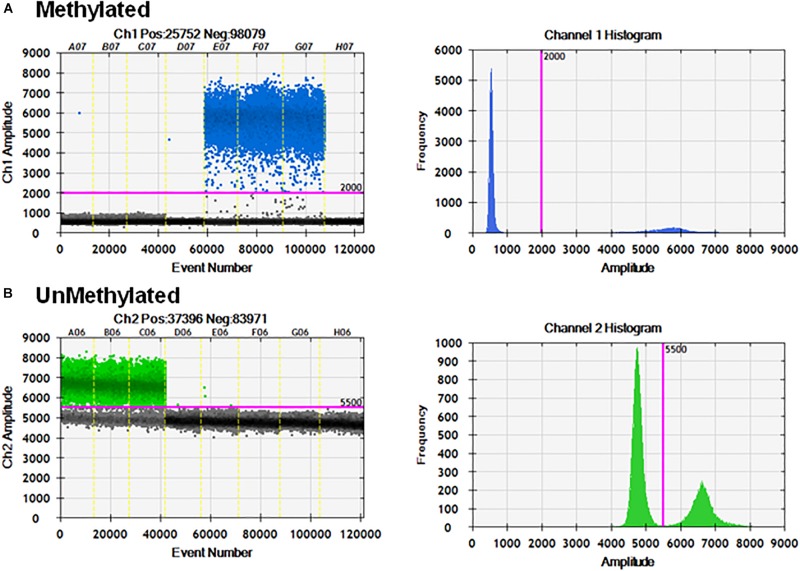
Specificity of ddMSP assay. ddPCR in the presence of mixtures of methylated and unmethylated plasmids. (A) Methylation probe and primers can only detect methylated CpGs and cannot detect unmethylated CpGs. (B) Unmethylation probe and primers can only detect unmethylated CpGs and cannot detect methylated CpGs.